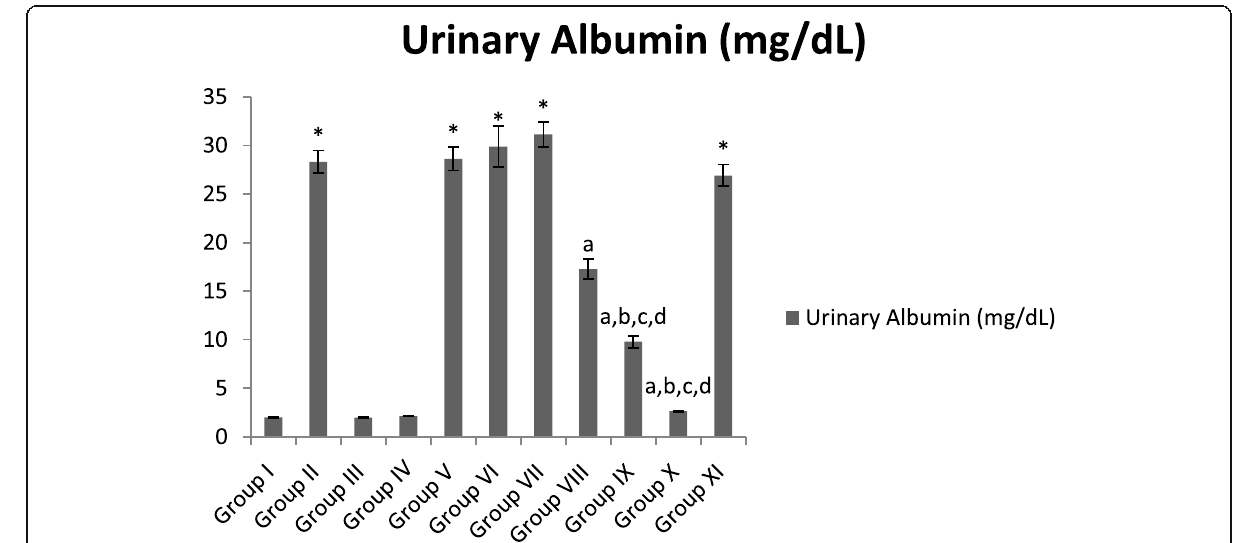
Fig. 4 Graph representing urine albumin levels (mg/dL). All values were represented as mean ± SEM. *= p < 0.001 versus group I (normal control); a = p < 0.001 versus group II (uninephrectomised diabetic control); b = p < 0.005 versus group V (uninephrectomised diabetic rats with oleamide (1mg/kg) treatment; c = p < 0.005 versus group VI (uninephrectomised diabetic rats with oleamide (2.5mg/kg) treatment); d = p <